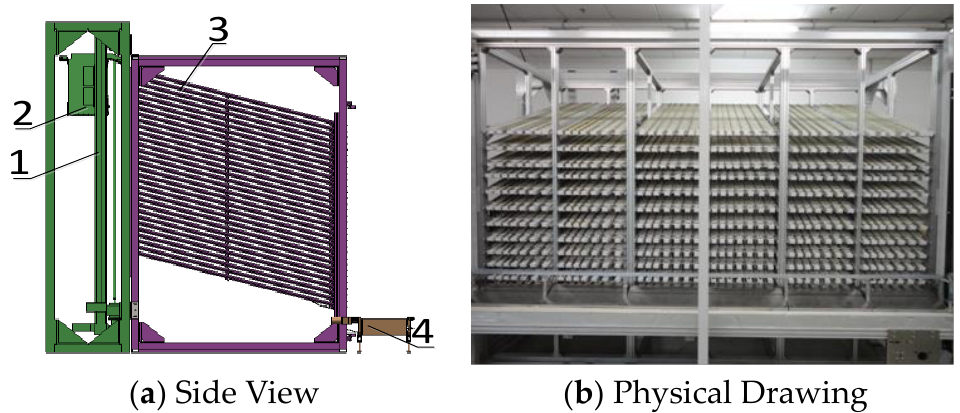
Figure 1. 3D and physical picture of the medicine storage system. 1. Cartesian coordinate robot. 2. Dispensing manipulator 3. Sloping drug storage 4. Automatic drug delivery device.